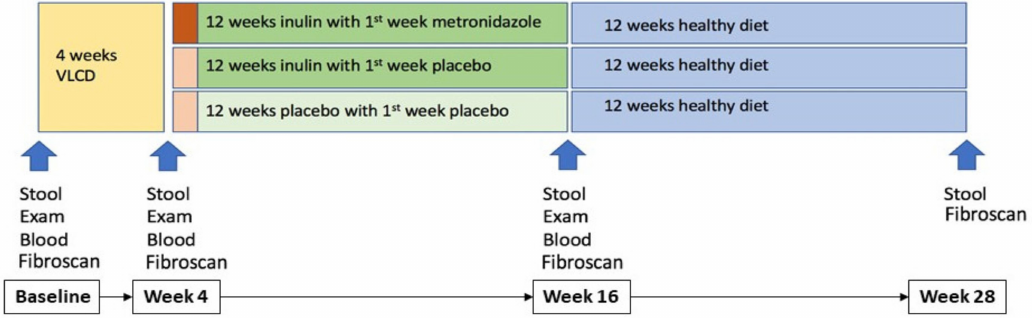
Figure 1. Assessment and sample collection